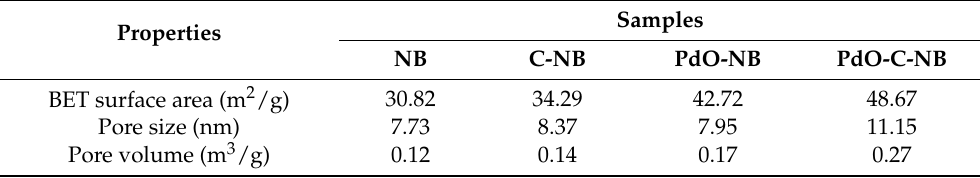
Table 6. The specific surface area, average pore size, and pore volume of various photocatalysts [94].